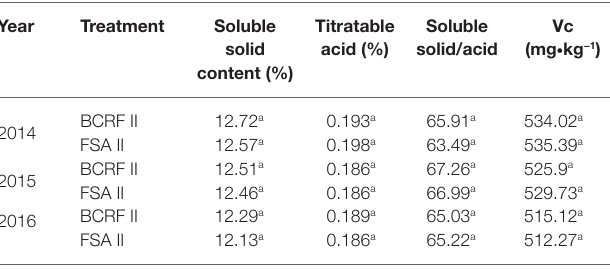
Different letters indicate statistically significant differences (p < 0.05).